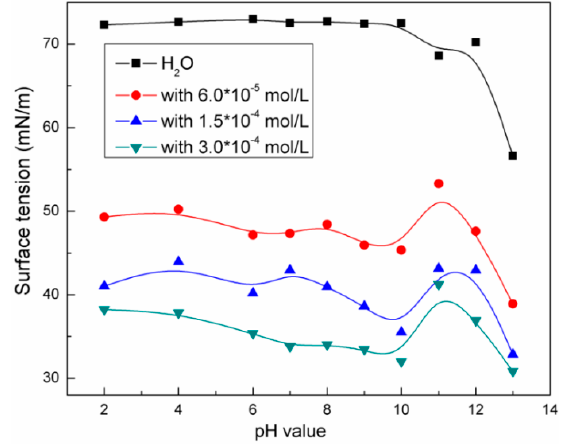
Figure 7. Surface tension of water and NaOL solution with different concentrations as a function of pH.